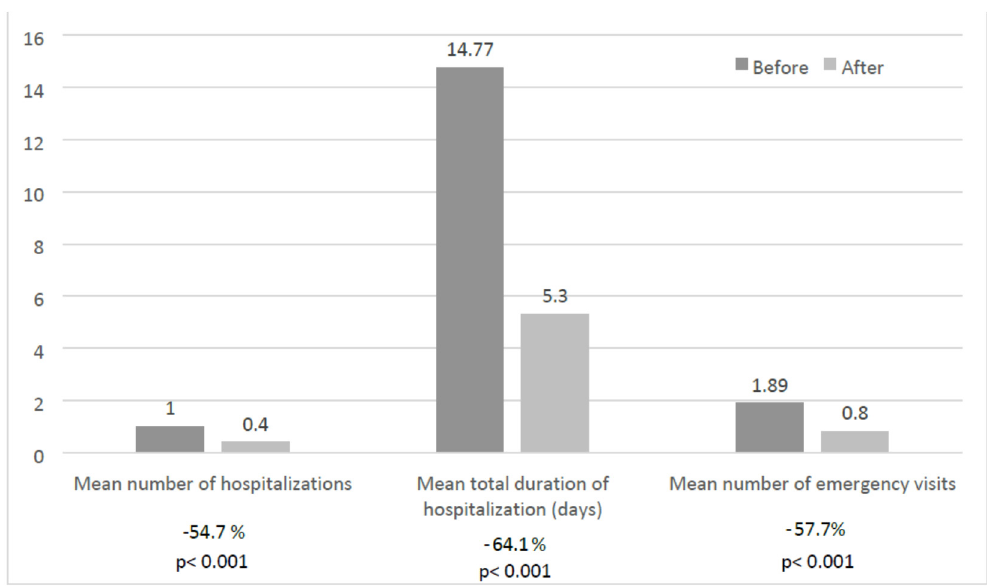
Figure 1. Health-care resources consumption before and after treatment with the HDSF. The reduction Figure 1. Health ‐ care resources consumption before and after treatment with the HDSF. The in health-care resources consumption after HDSF is expressed as percentage and included under reduction in health ‐ care resources consumption after HDSF is expressed as percentage and included the under the bars.